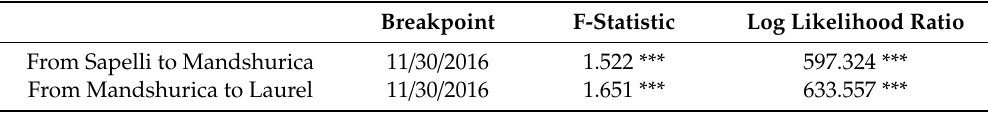
Table 1. Chow test